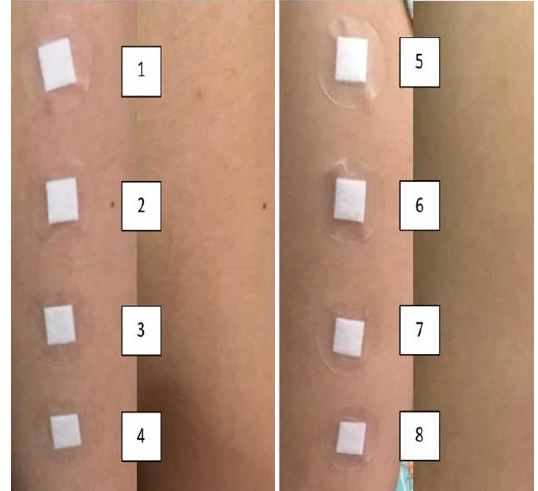
Figure 3 . Skin sensitivity assay of Streptococcus macedonicus MBF10-2 fractions on the skin of Indonesian young adult